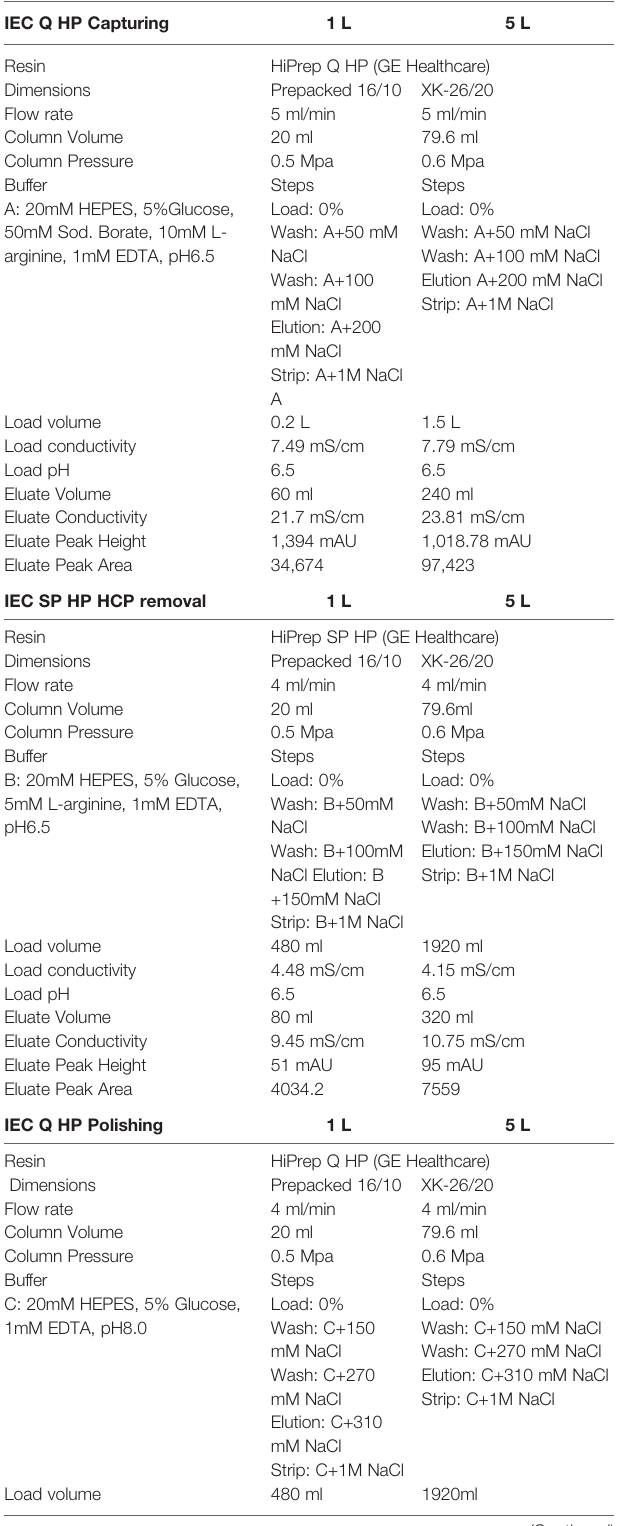
TABLE 1 | Column parameters for the puri fi cation of